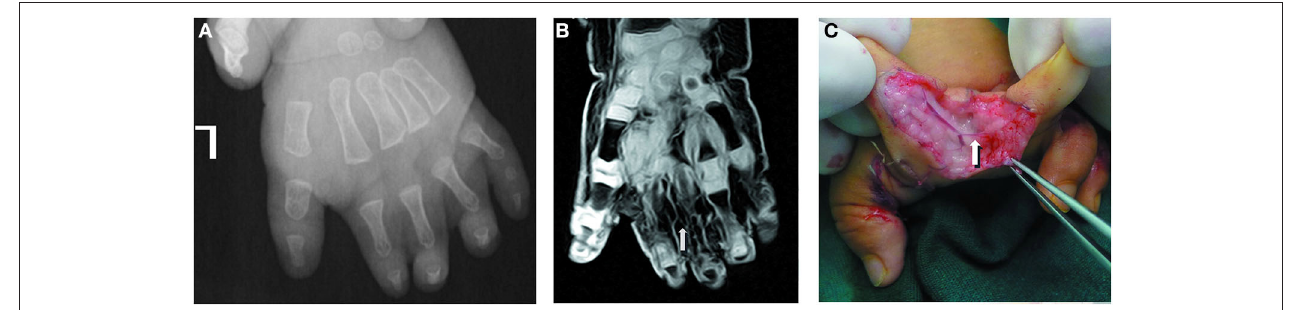
FIGURE 3 | A 13-month-old male patient with complicated syndactyly of the left 1st-2nd-3rd-4th-5th digits. (A) The preoperative radiograph showed the fused extent of proximal soft tissues of the 1st-2nd-3rd-4th-5th webspaces and only two phalanges of the 2nd-3rd-4th digits. (B) A contrast-enhanced three-dimensional water selective cartilage scan indicated that the proper palmar digital artery of the radial side of the 3rd finger (white arrow) was thin. (C) This was completely consistent with the intraoperative observation results.